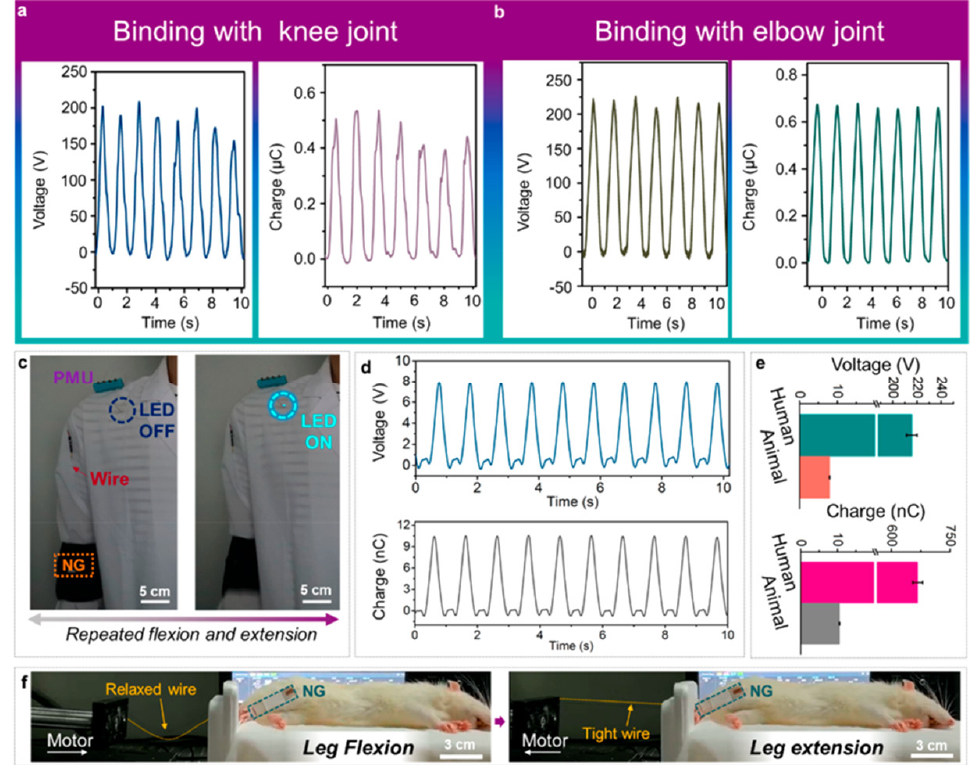
Figure 27. Experimental results of the output performance of the ts-PENG tested in human and rat models [113]. The open-circuit voltage and short-circuit transferred charge of the ts-PENG placed on ( a ) the knee joint and ( b ) elbow joint. ( c ) Test of the ts-PENG system to light an LED. ( d ) The open-circuit voltage and short-circuit transferred charge of the ts-PENG attached to the leg of a rat model. ( e ) Average results of the open-circuit voltage and short-circuit transferred charge of the ts-PENG tested on the human and rat models. ( f ). Image of the ts-PENG tested on the leg of the rat model. Reprinted with permission from [113]. Copyright ©2020, American Chemical Society.